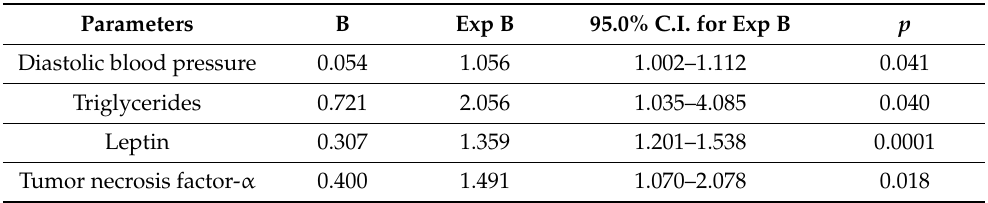
Table 6. Results of a step-by-step regression analysis of the association of adipokines/cytokines with the presence of AO against a background of hyper-LDL-C in women aged 25–44